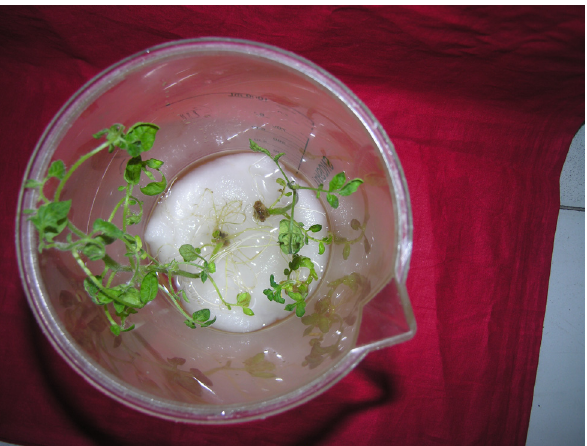
Fig. 4. Hardening of plantlets on moist